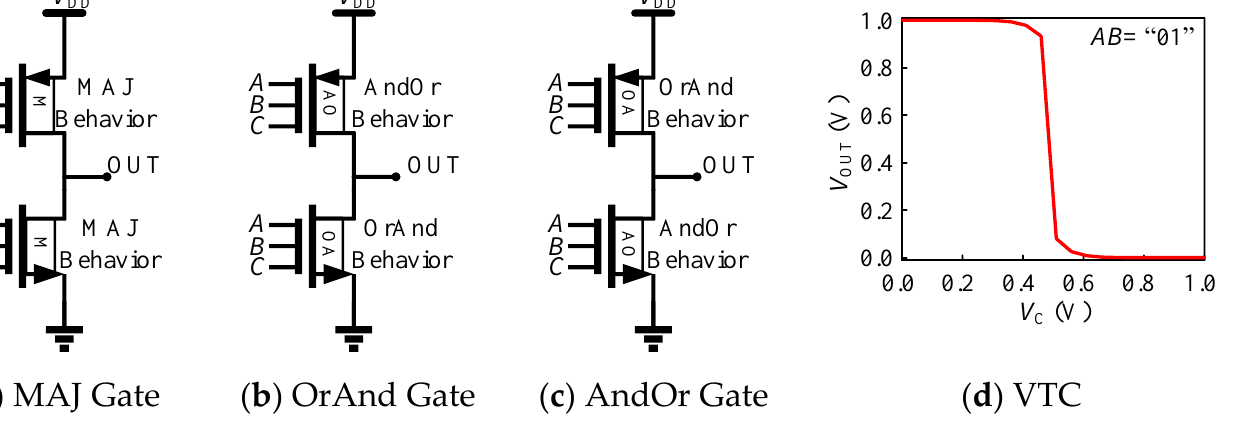
Figure 14. ( a – c ) Construction of compact MAJ gate, OrAnd gate, and AndOr gate based on three- input TFETs. ( d ) VTC characteristic curve of MAJ gate, where AB = “01”.